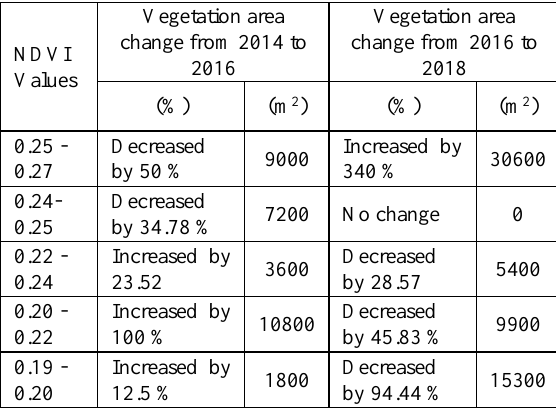
Table 1: Vegetation health changes between 2014 – 2016